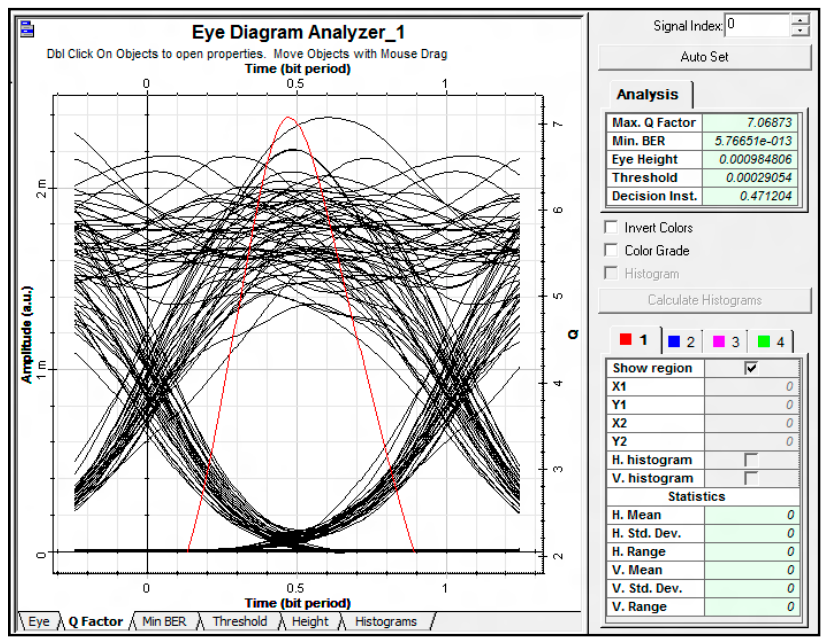
Figure 7. BER with transmission distance of SAC-OCDMA system using EDW codes with APD detector, PIN detector, and PIN detector in the presence of EDFA.